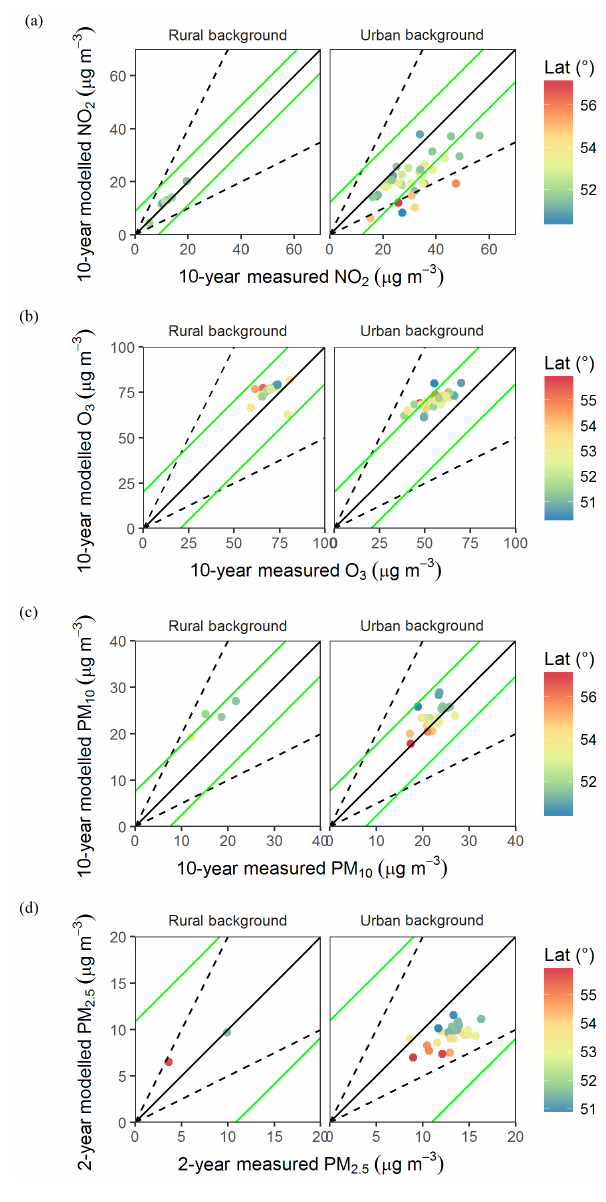
Figure 1. Scatter plots of the 10-year means of the modelled and measured pollutant daily metrics at each site, grouped by site type, and with data markers shaded according to the latitude of the mea- surement site: (a) NO 2 ; (b) O 3 ; (c) PM 10 ; (d) PM 2 . 5 . The val- ues of r , FAC2, NMB, and RMSE associated with the data in each plot are given in Table 1. The solid and dashed lines are the 1 : 1, and 2 : 1 and 1 : 2 lines, respectively. The green lines bound the respective model quality objective calculated using the formulae published in FAIRMODE project WG 1 documents at http://fairmode.jrc.ec.europa.eu (as at March 2017) and allowing for variable measurement uncertainty using the measured values in this study. See the main text for further details.